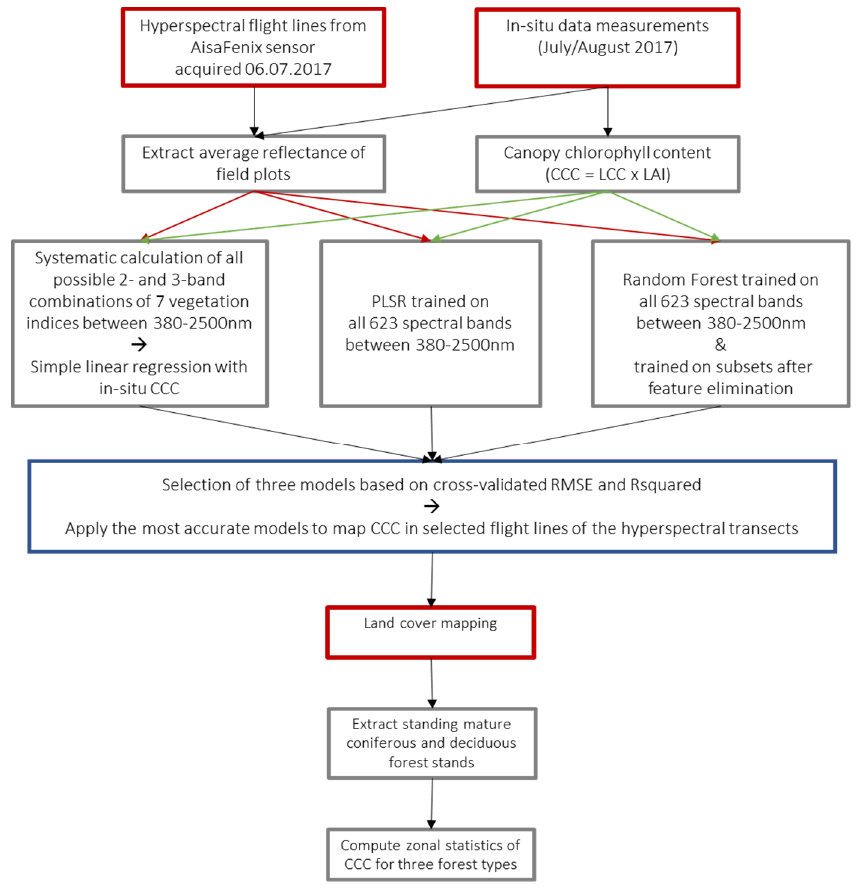
Figure 2. Methodological framework of the study. Red rectangles are representing input data, grey analysis steps and blue outputs.